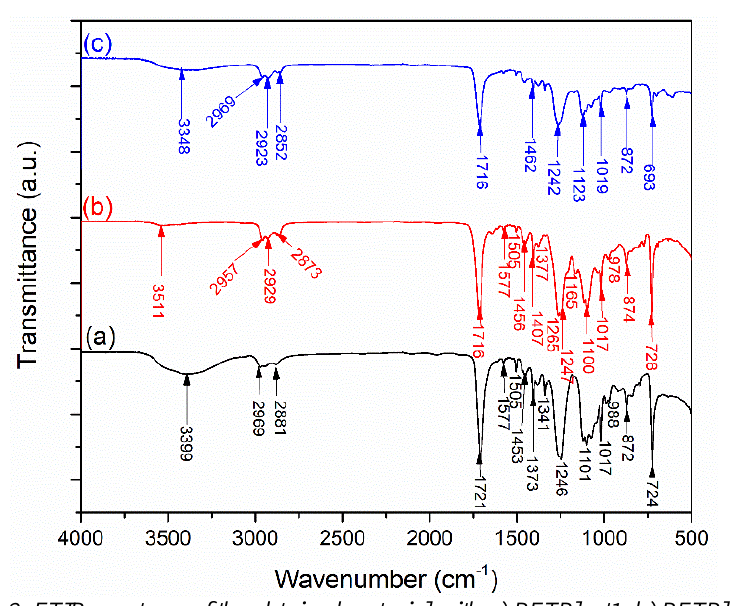
Fig. 2. FTIR spectrum of the obtained material with a) PETPlast1, b) PETPlast2 plasticizers and c) FR Sample 3.